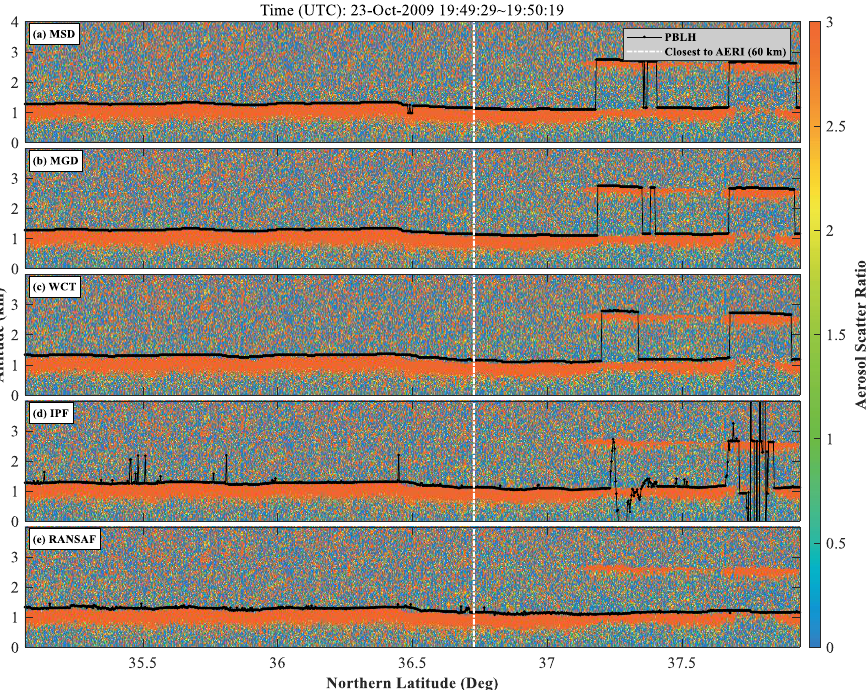
Figure 7. ASR was measured by CALIOP from 19:49:29 to 19:50:19 on 23 October 2009 (UTC, daytime); PBLHs were determined with ( a ) MSD, ( b ) MGD, ( c ) WCT, ( d ) IPF, and ( e ) RANSAF methods.